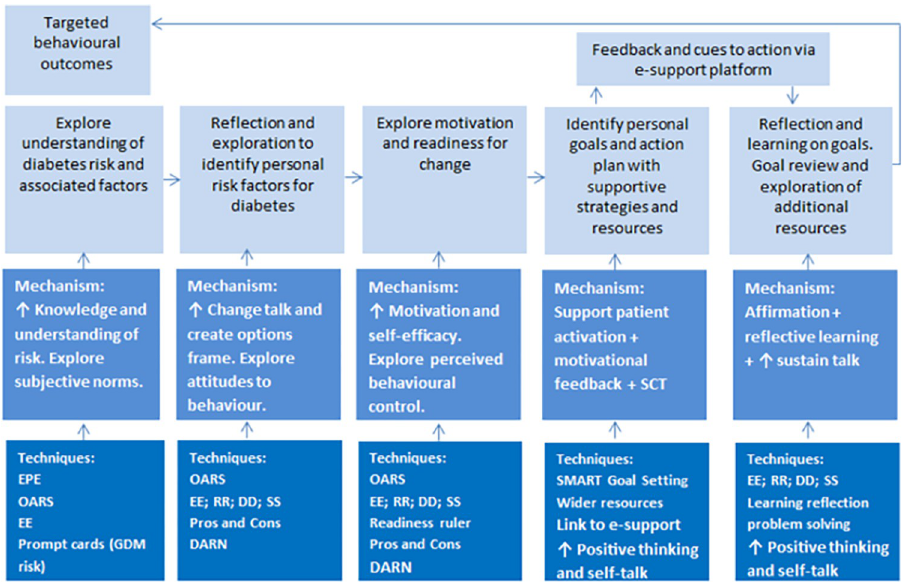
Fig 3. Estimated marginal means weight change between pregnancy booking and